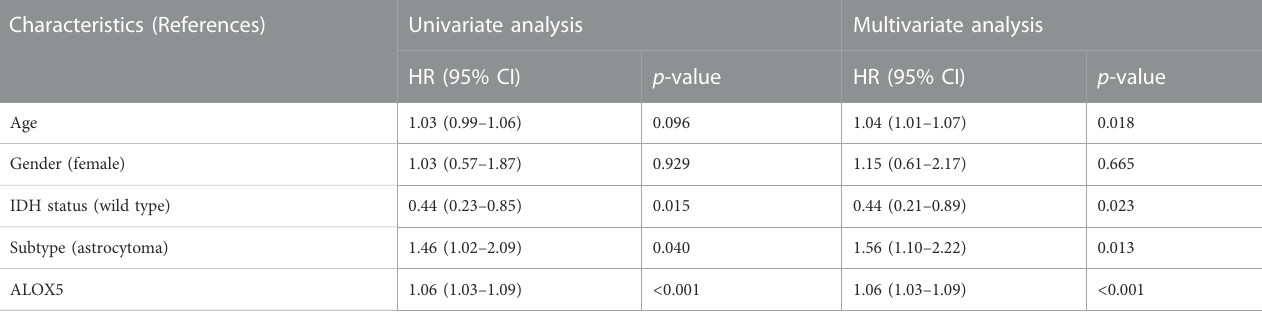
TABLE 5 Cox regression analysis of the association of ALOX5 and clinical variables with OS in the CGGA-LGG dataset. Characteristics